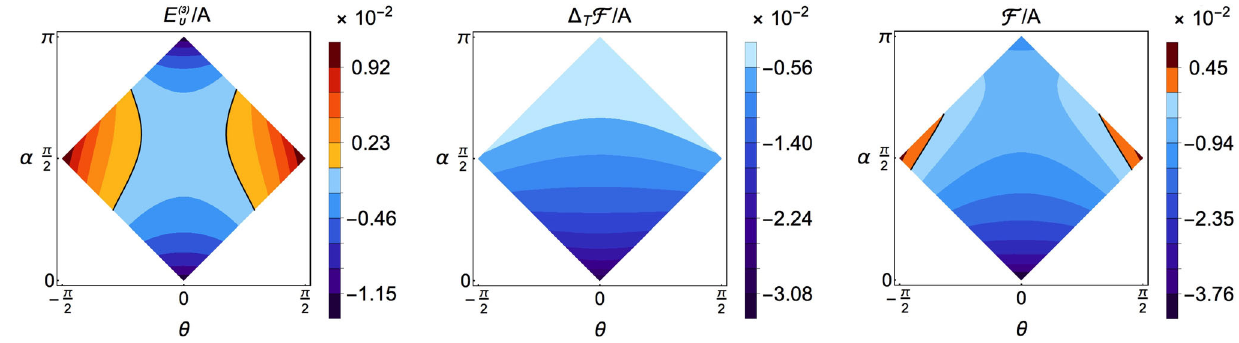
Fig. 2 Quantum vacuum energy per unit area at T = 0 (left), thermal correction Δ T F / A (center) and total Helmholtz free energy per unit area (right) as functions of the parameters α and θ . In these plots, T = 0 . 55 , n 1 = 0 and L = 1